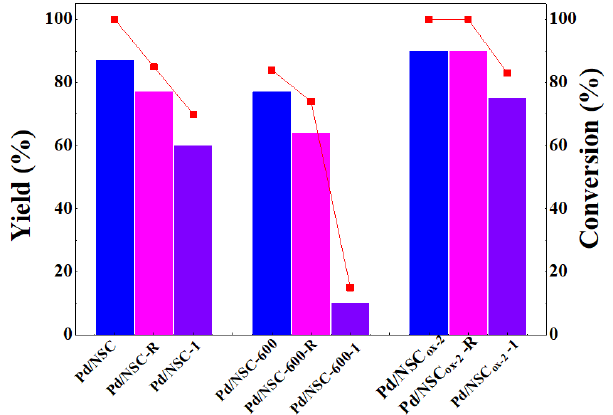
Figure 2. Yields of the product (columns) and conversions (points) of TADB in the hydrogenolysis reaction over various catalysts. Pd/NSC-1, Pd/NSC-600-1, and Pd/NSC ox-2 -1 presented the re-used catalysts.